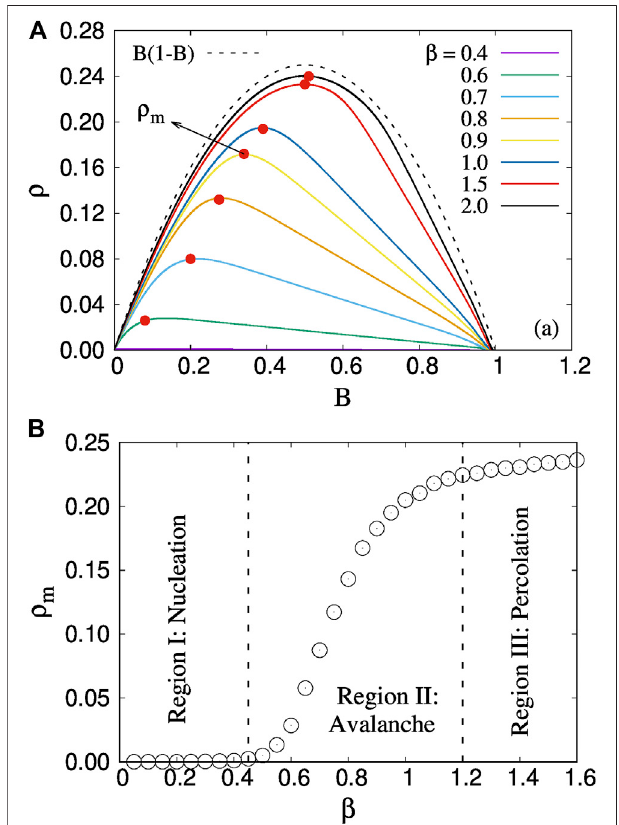
FIGURE 1 | (A) Variation of patch density ρ with fraction broken B for β values ranging from 0.4 to 2.0. The red dots denotes ρ m , the maximum possible patch density. The dotted line is the locus of B (1 − B ) and represents random failure events for a 1d bundle. (B) Variation of ρ m as the disorder strength β is varied continuously. We see three different regions (1) ρ m is 1/L here suggesting a single crack propagates through the bundle in a nucleating manner(2)Here number ofcracksoriginates and the number increaseswith β (3) The failure process here random in space. ρ m has a value close to 0.25 here. The system size is kept constant at 10 5